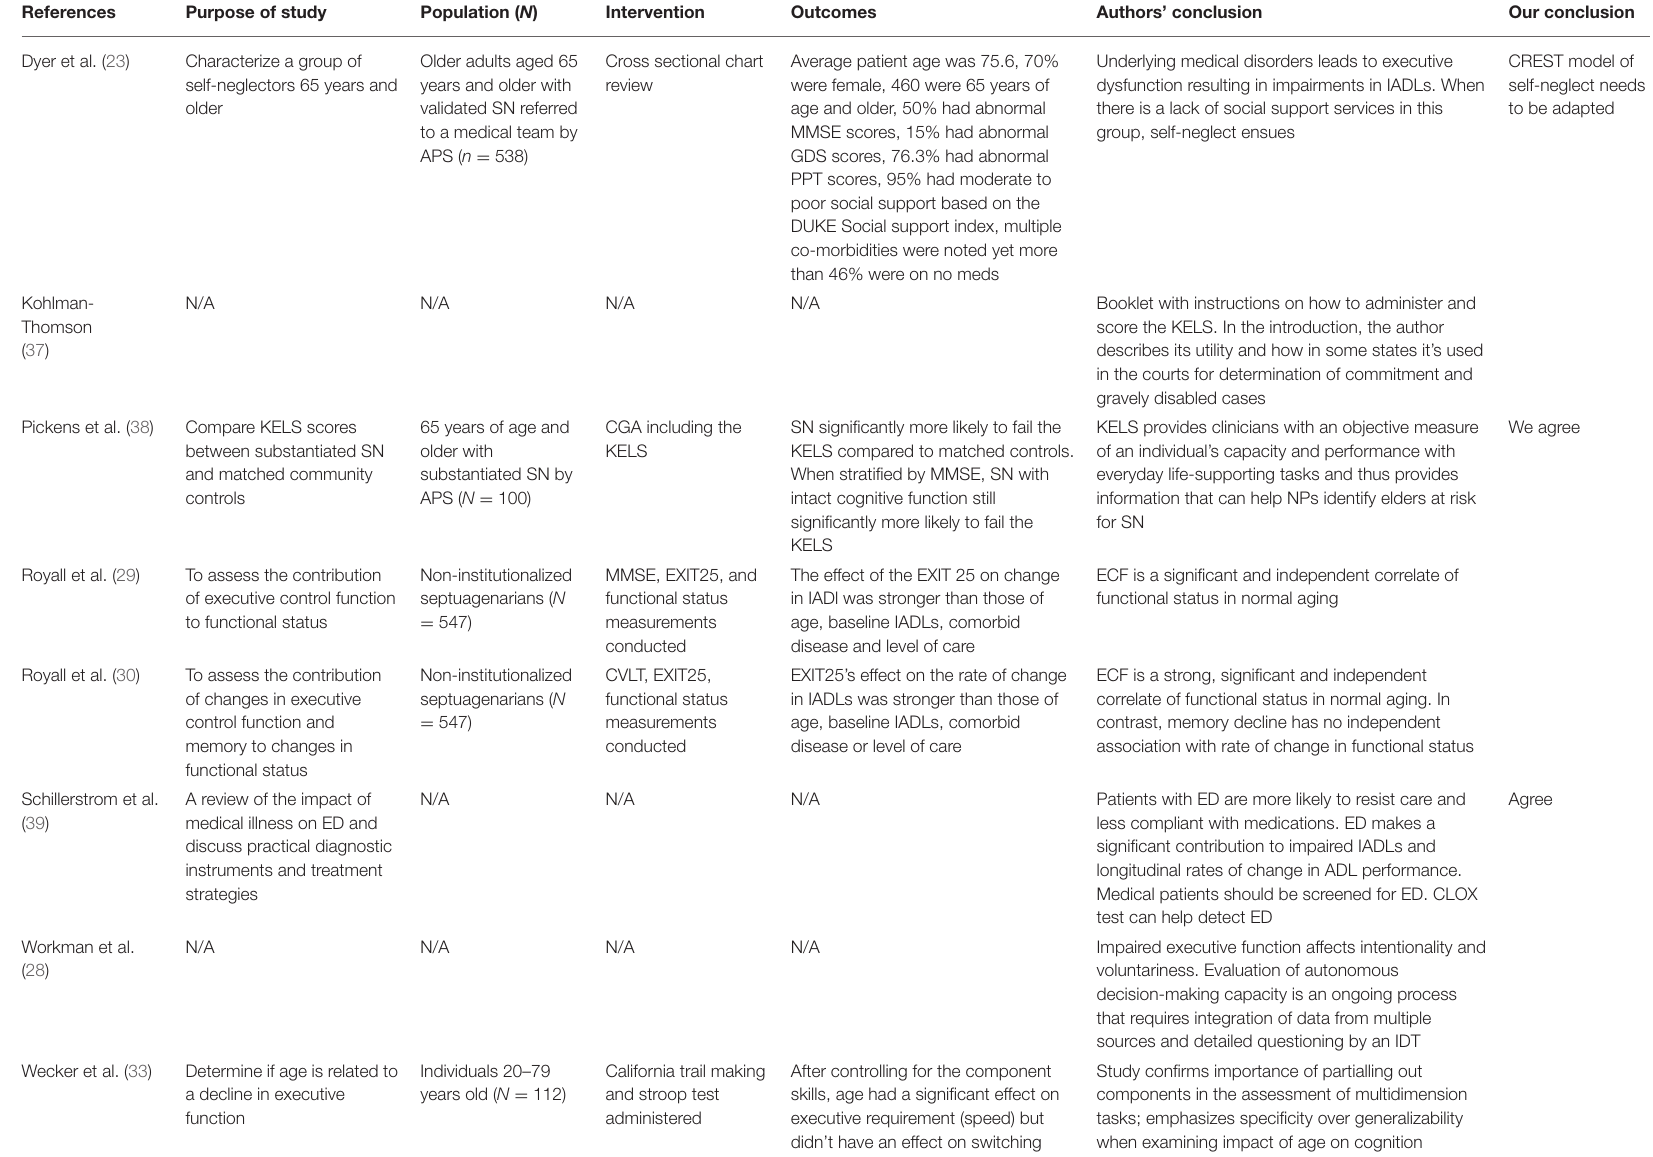
TABLE 2 | Executive dysfunction may increase the development of